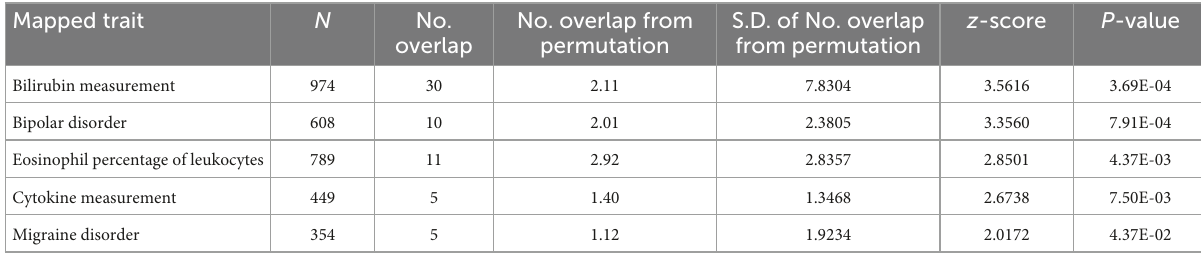
TABLE 3 Summary of an enrichment of vascular endothelial function associated genes that overlap loci previously linked to phenotypes in GWAS studies. Mapped trait